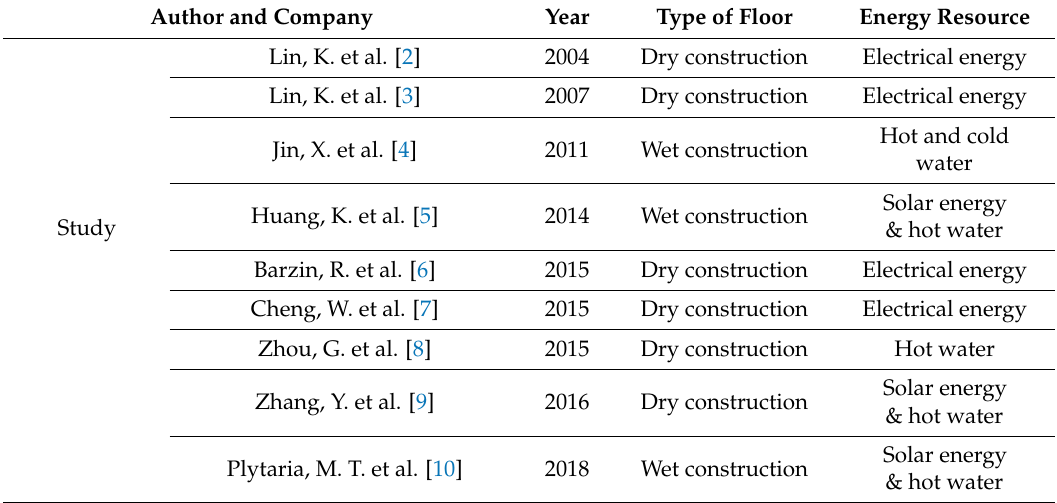
Table 1. Previous studies on phase change material (PCM) radiant floor heating